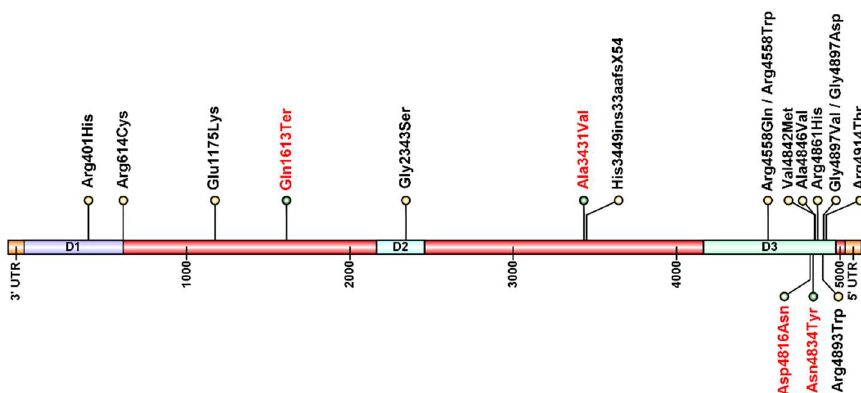
Figure 3. Diagram of the variants in the RYR1 gene in this cohort of patients. Novel variants identified in this work are depicted in red and previously described variants are represented in black. D1, D2, and D3 are the three hotspots for mutations in the RYR1 gene, and the majority of the variants identified in this cohort are located at D3. Figure created using IBS Illustrator for Biological Sequences [19].